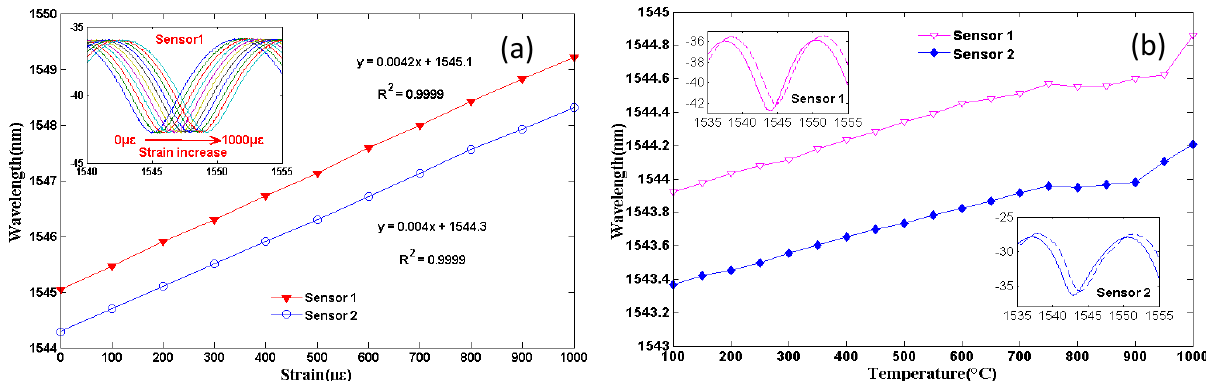
Figure 6. The sensing applications of the air-bubble-based FPI with 91 μm air bubble: ( a ) the strain sensitivity, inset is the shifts of one of the interference dips as the strain increases; ( b ) the temperature sensitivity, inset is the shifts of the interference dip at 100 °C (solid curve) and 1,000 °C (dashed